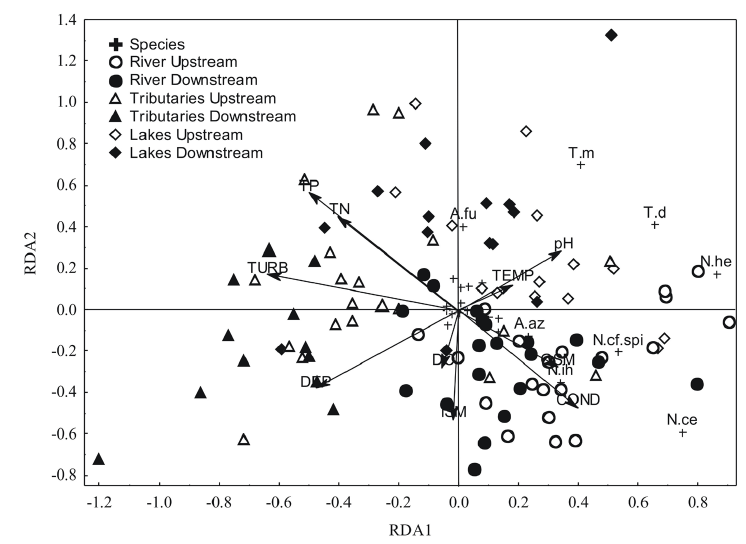
Figure 8. Bidimensional representation of Redundancy Analysis (RDA) between copepod abundances and environmental variables of the sampling sites. COND = conductivity; TN = total nitrogen; DEP = depth; TP = total phosphorous; TEMP = temperature; TURB = turbidity; DO = dissolved oxygen; SOM = suspended organic matter; SIM = suspended inorganic matter. Species: A.az = A . azevedoi ; A.fu = A . furcatus ; N.ih = N . iheringi ; T.m = T . minutus ; T.d = T . decipiens ; N.he = N . henseni ; N.cf.spi = N . cf. spinuliferus ; N.ce = N . cearensis . For better visualization, only species mostly associated to each axis are